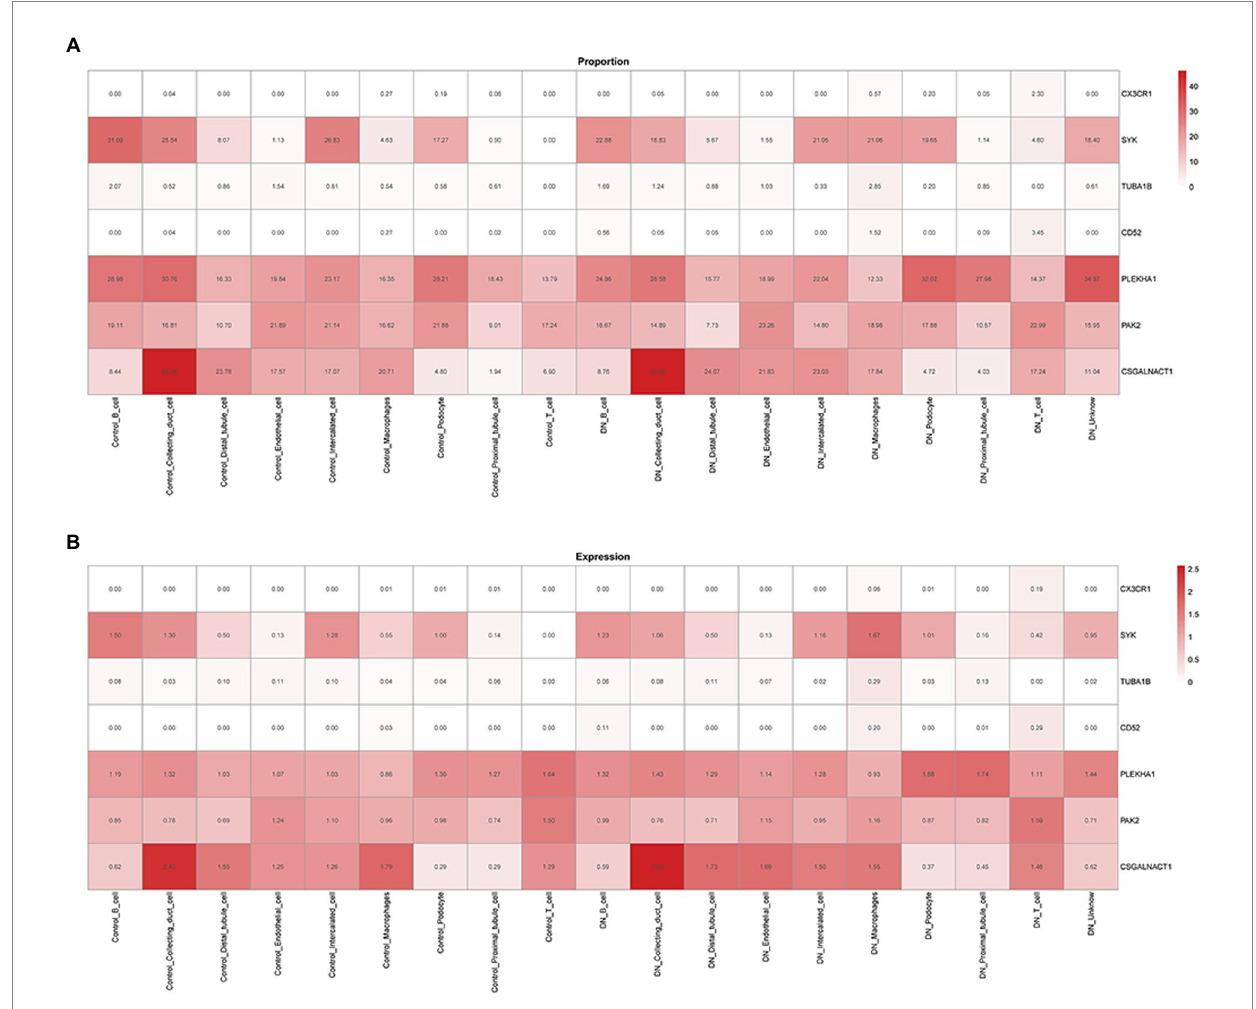
FIGURE 6 Relationship between biological markers. (A) The relationship between PLEKHA1 and CSGALNACT1. (B) The relationship between PLEKHA1 and